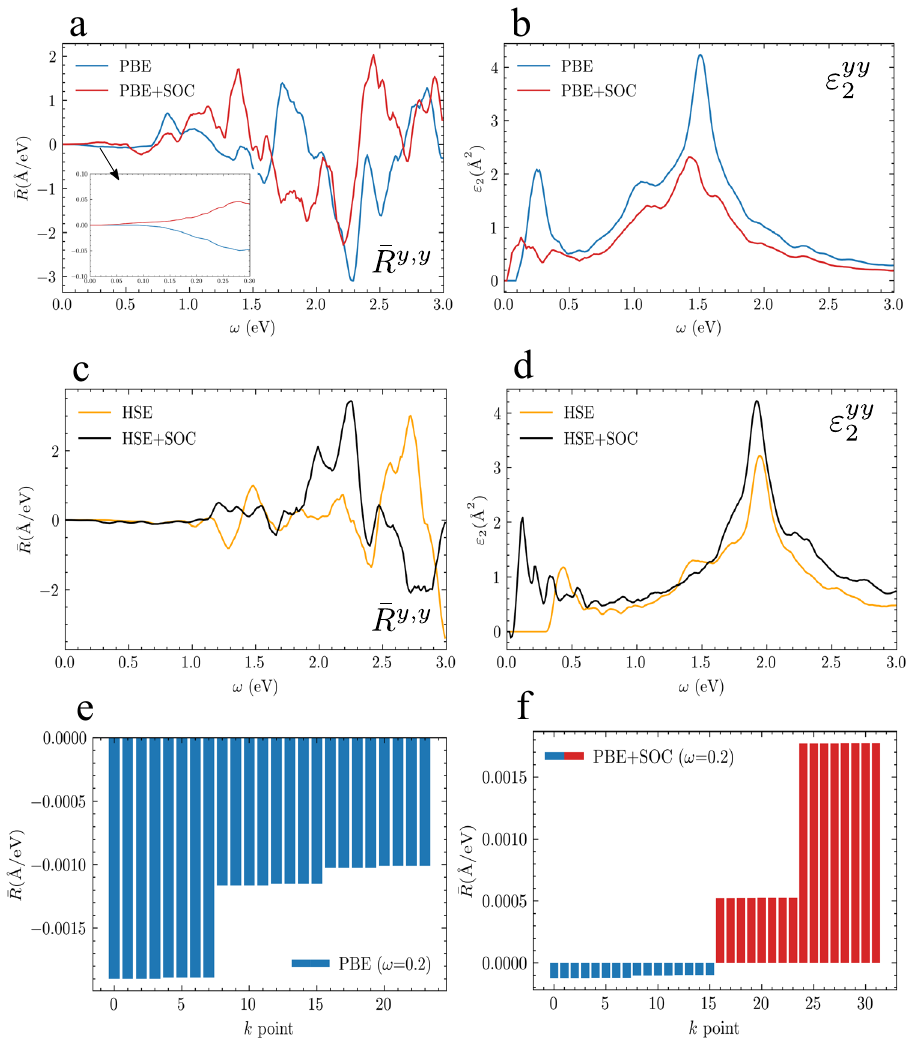
y ; y ) and transition intensity ( ε yy ) for σ yyy in 2 estimated with b PBE and PBE + SOC and d HSE and HSE + SOC. 2